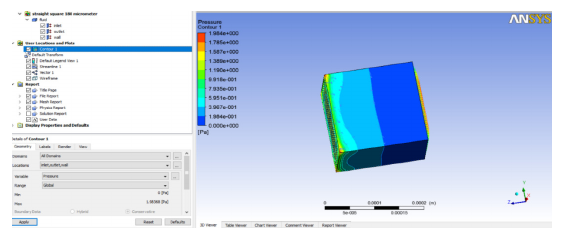
Fig. 13: Contour Pressure for Simulation